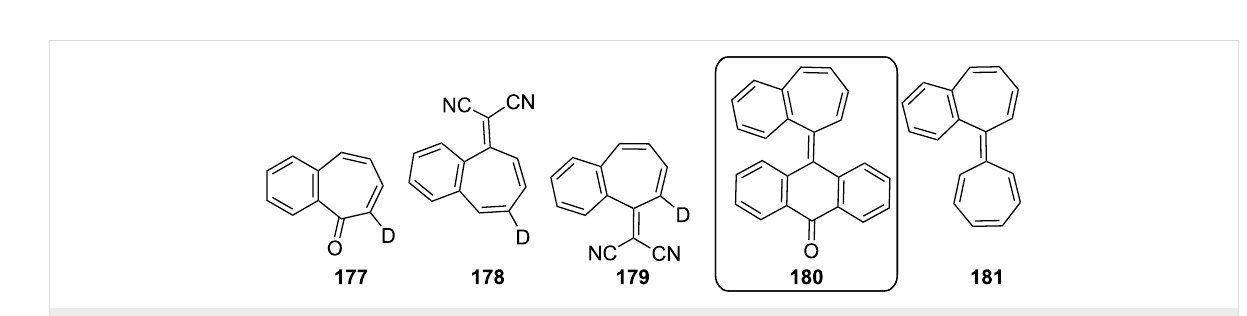
Figure 6: Benzoheptafulvenes as condensation products of 2,3-benzotropone ( 12 ).